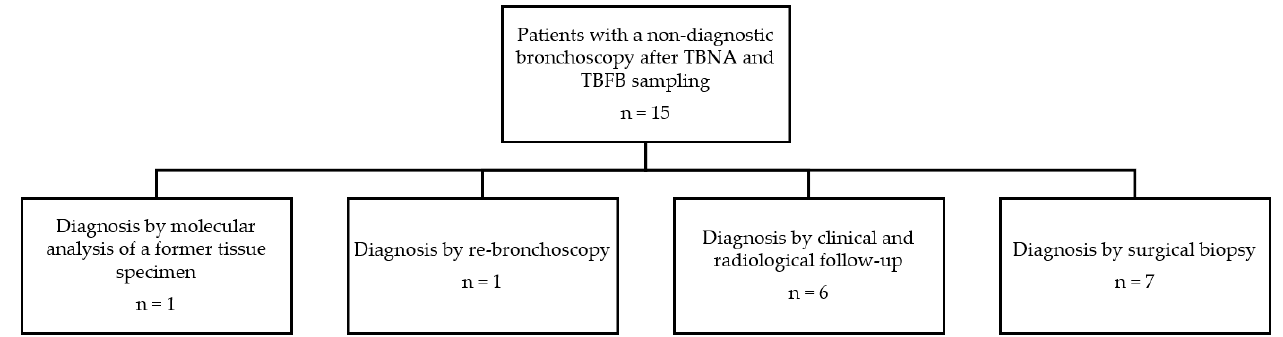
Figure 2. Further diagnostics or follow-up in patients with a nondiagnostic bronchoscopy after TBNA and TBFB sampling, Abbreviations: TBNA = transbronchial needle aspiration, TBFB = transbronchial forceps biopsy.